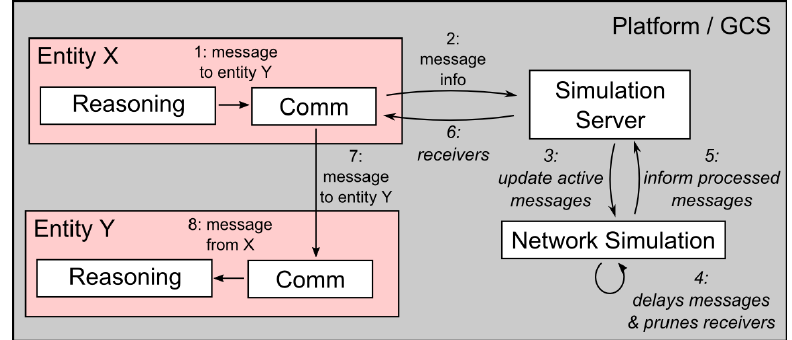
Figure 6. Principle of the deployment of the network simulation into MR